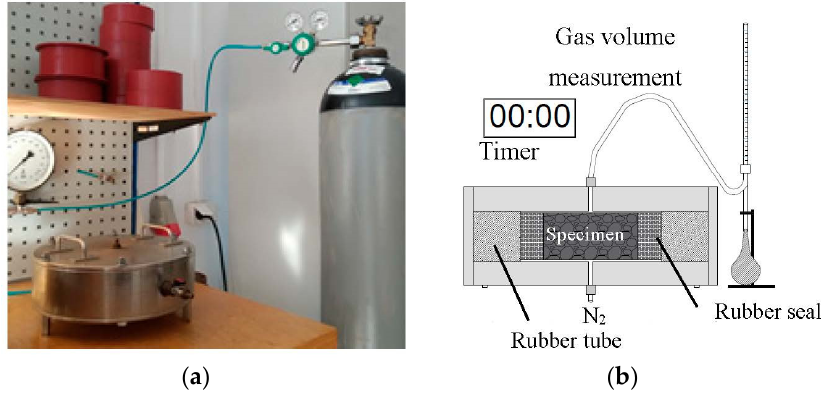
Figure 2. ( a ) Gas permeability cell; ( b ) scheme of gas permeability